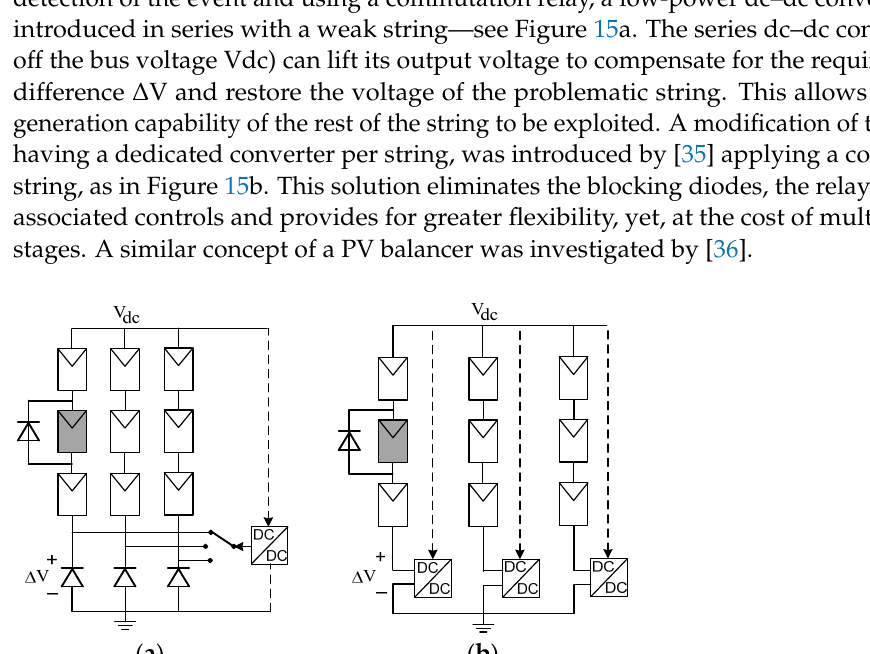
( b ) Figure 16. Conceptual PV generation control circuit: Type A operated on output terminal power ( a ); Type B operated on autonomous power ( b ) [37].